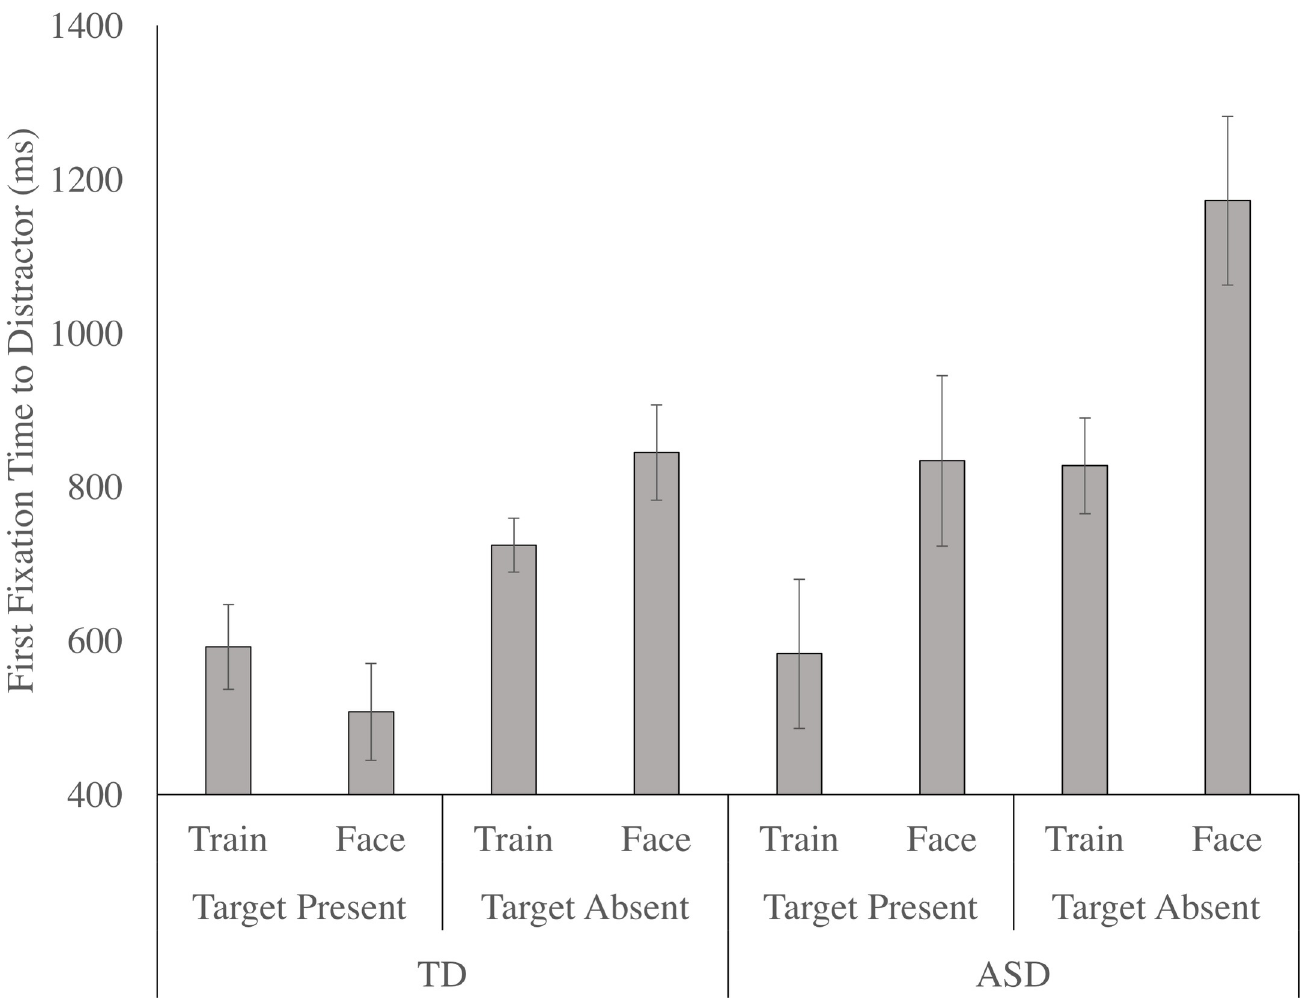
Fig 6. The time elapsed between the beginning of the trial and the first fixation to the distractor, or the first fixation time to distractor (mean and standard error), for both the autistic and non-autistic children in the upright condition as a function of target (present, absent) and distractor (train, face).